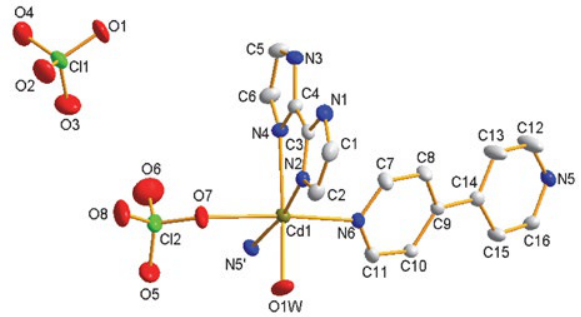
Figure 1. An ORTEP diagram of complex 1 with 30% thermal ellip- soids. Hydrogen atoms are omitted for clarity. Symmetry code: – x – ½, y + ½, z – ½.